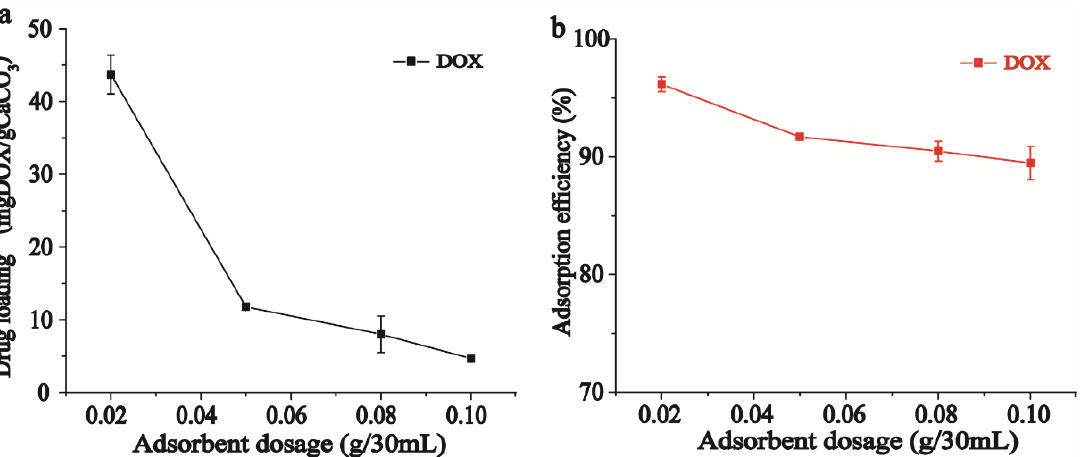
Figure 4. The effect of adsorbent dosage on DOX adsorption using BV. ( a ) Drug loading. ( b ) Efficiency of drug encapsulation.